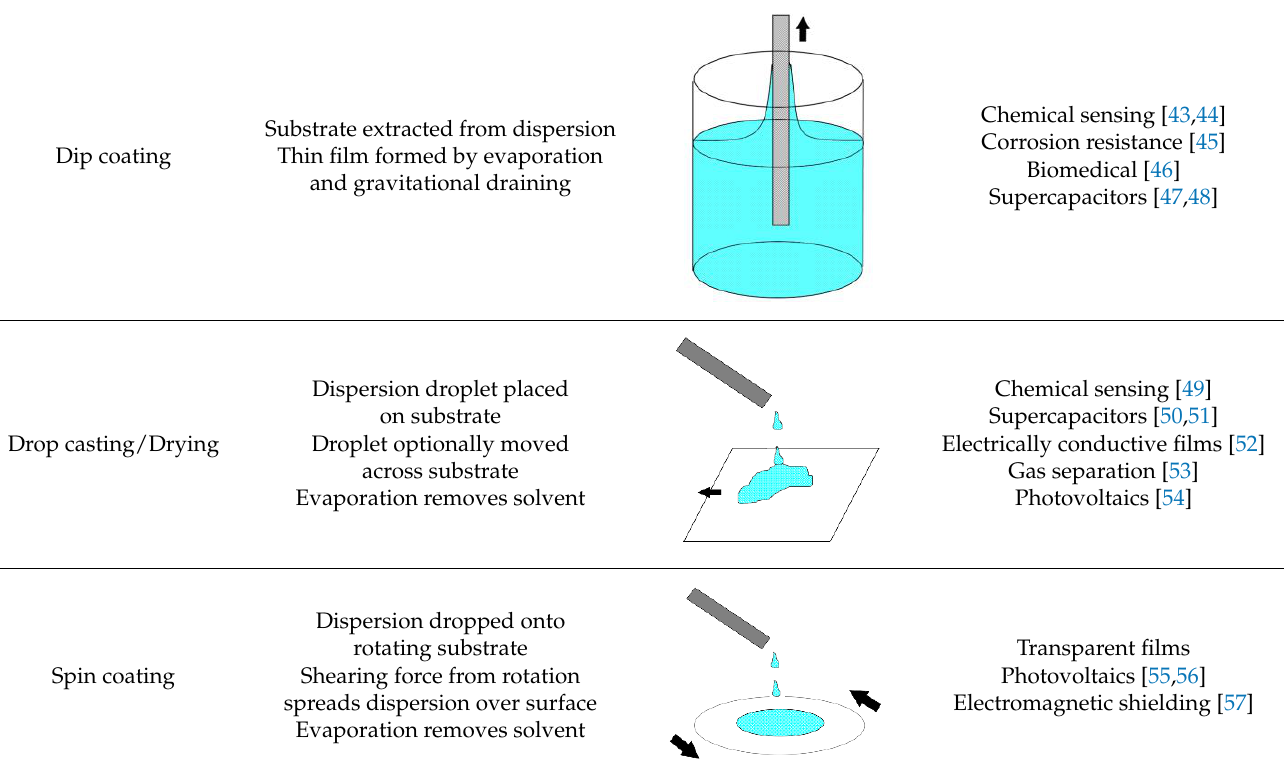
Table 1. Schematics and applications of thin-film fabrication techniques for MWCNT dispersions and slurries. Fabrication Technique